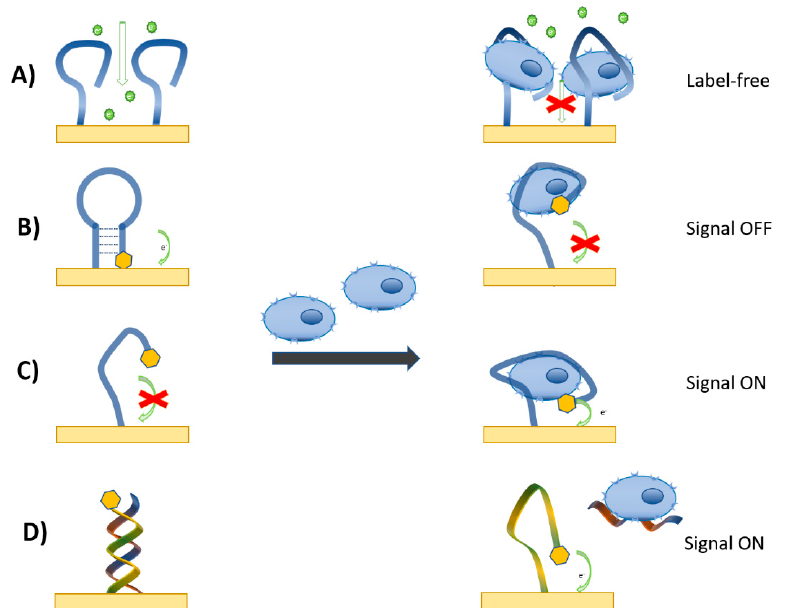
Figure 7. The scheme of various designs of the electrochemical aptasensors for the detection of cells. ( A ) Label-free detection in the presence of the redox couple in a buffer. ( B ) Aptamer beacon. ( C ) Signal-on configuration. ( D ) Signal-on configuration using aptamer hybridized with complementary chain. For explanation, see the text above.